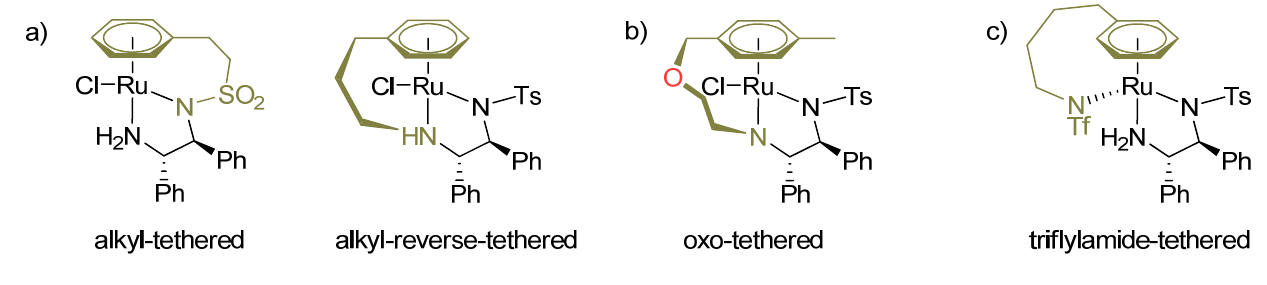
Figure 5. Examples of tethered complexes of Wills and